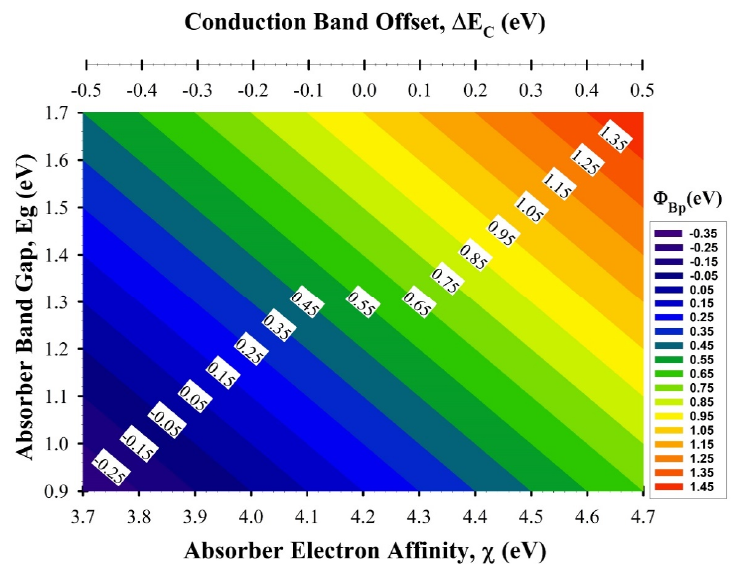
Figure 2. Back contact barrier height ( Φ Bp ) as a function of band gap and electron affinity (top x -axis correlates with the resulting CBO values) of the absorber layer.